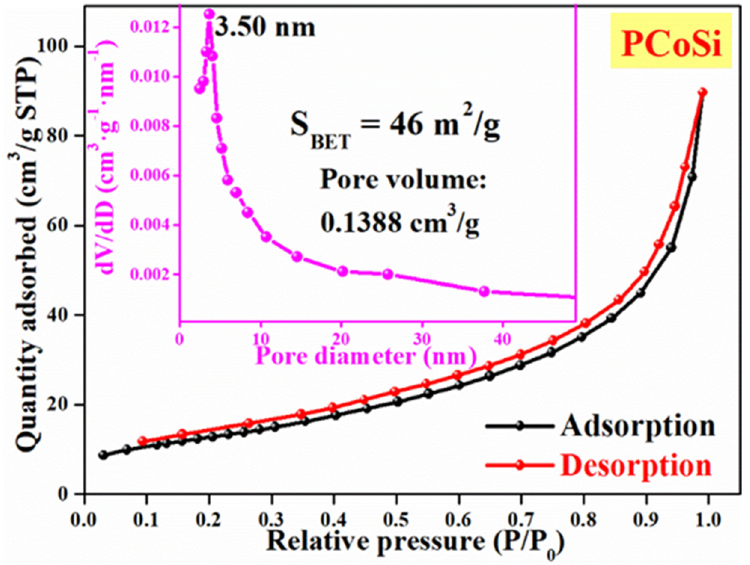
Figure 4. N 2 adsorption-desorption isotherms of PCoSi, inserting the corresponding pore size- distribution curve.